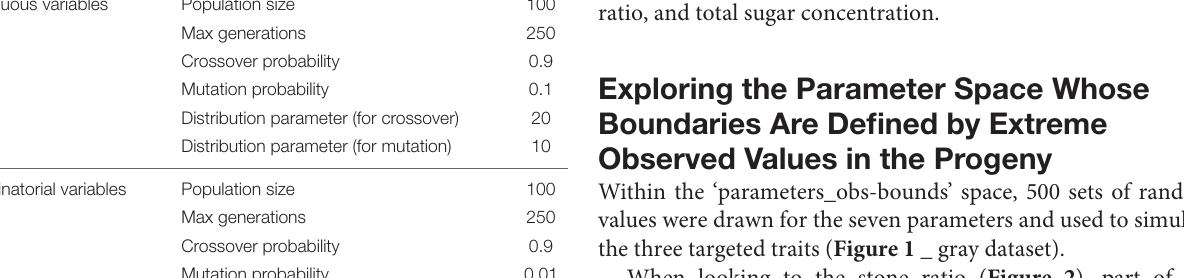
TABLE 2 | Parameters used in the NSGA-II algorithm for continuous and combinatorial variables.